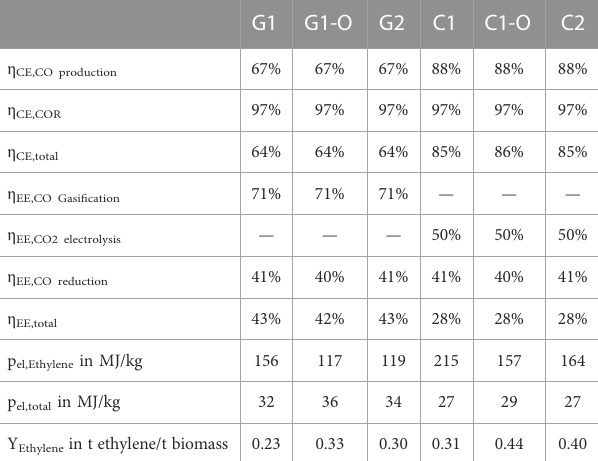
TABLE 4 Key performance